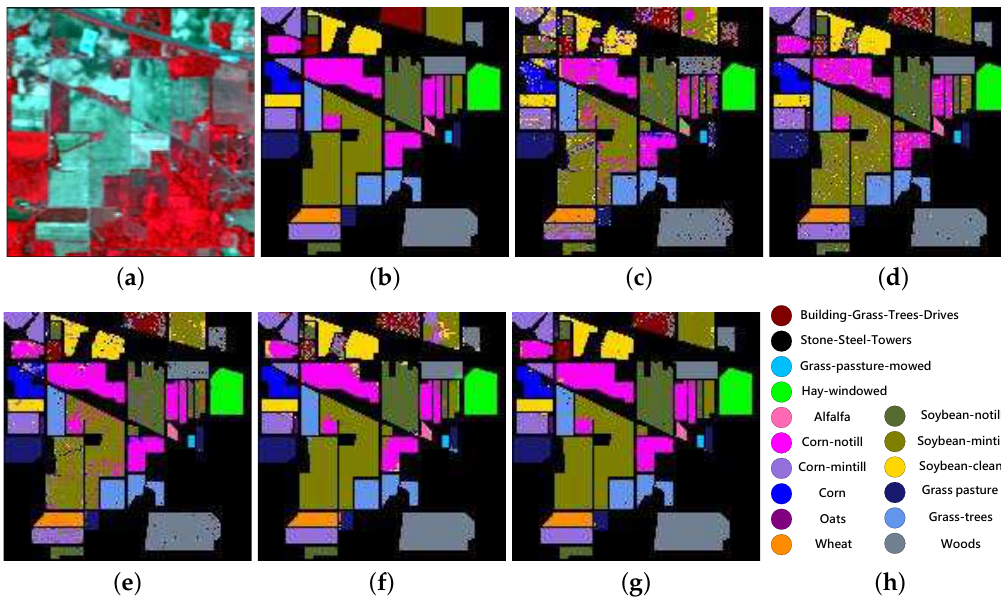
Figure 9. Classification maps using different methods on the Indian Pines dataset: ( a ) False-color image, ( b ) Ground-truth map, ( c ) RNN, ( d ) CNN, ( e ) ARNN, ( f ) ACNN, ( g ) SSAN. Table 9. Classification performance of different methods for the Indian Pines dataset. Bold indicates the best